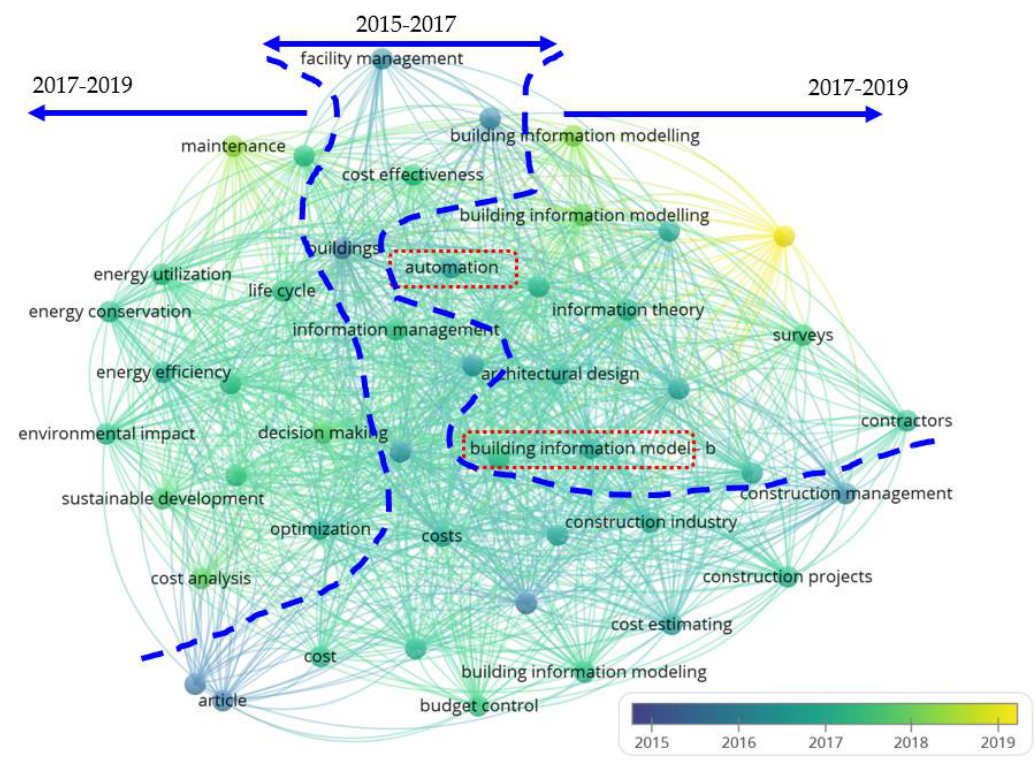
Figure 7. Co-occurrence network of themes created on CCM. Considering a minimum number of co-occurrences of 20, 47 keywords out of 5671 sample keywords are identified. Note: the greatest total link strength ranging was used for selecting co-authors.